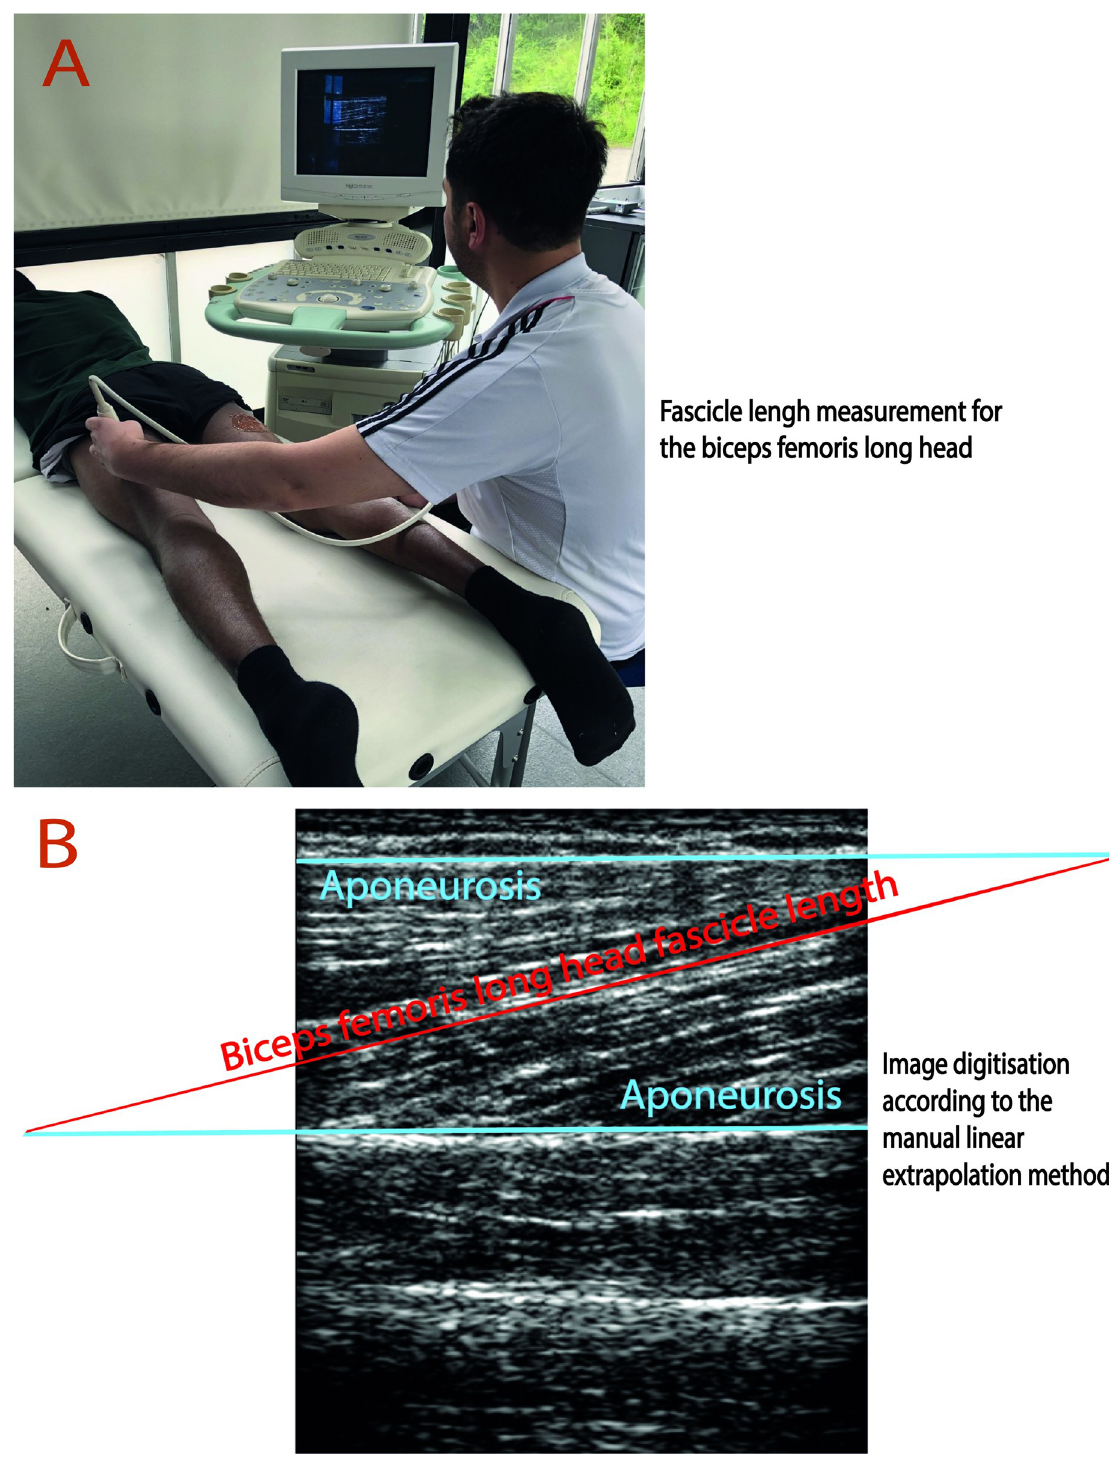
Fig 2. The biceps femoris long head fascicle length measurement and digitisation. A: 2-dimensional ultrasound images were taken from the mid-thigh for both legs. B: Digitisation for the biceps femoris long head fascicle length according to the manual linear extrapolation method. The individual pictured in Fig 2 has provided written informed consent (as outlined in PLOS consent form) to publish their image alongside the manuscript.